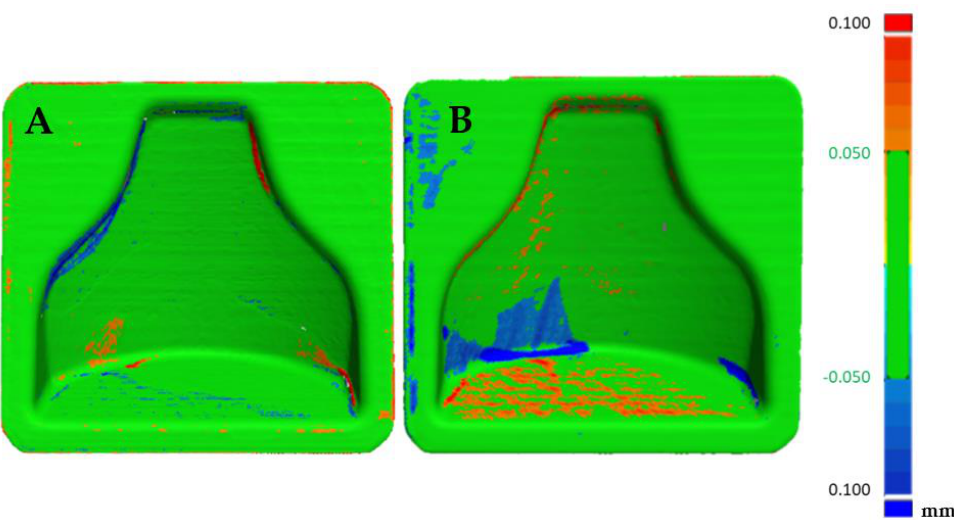
Figure 12. Zebra stripes effect on the two molds after printing. ( left ) mold 1 and ( right ) mold 2.